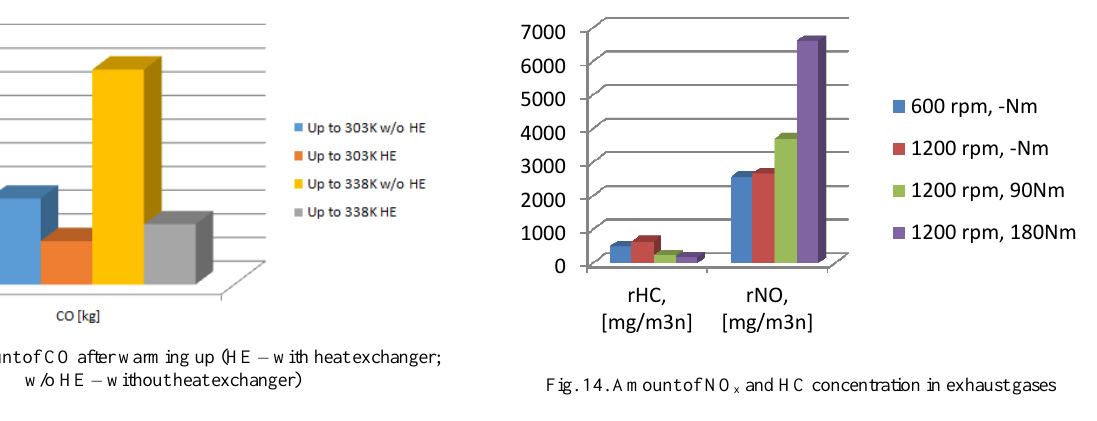
Fig. 14. Amount of NO x and HC concentration in exhaust